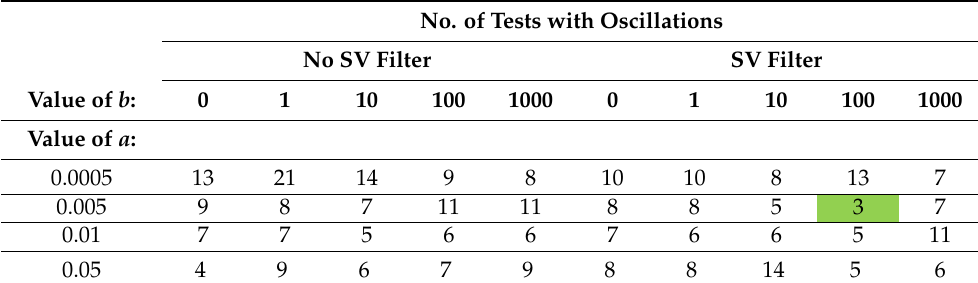
Table 2. The number of tests demonstrating poor performance for each combination of reward components. The best combination of parameters has been highlighted in